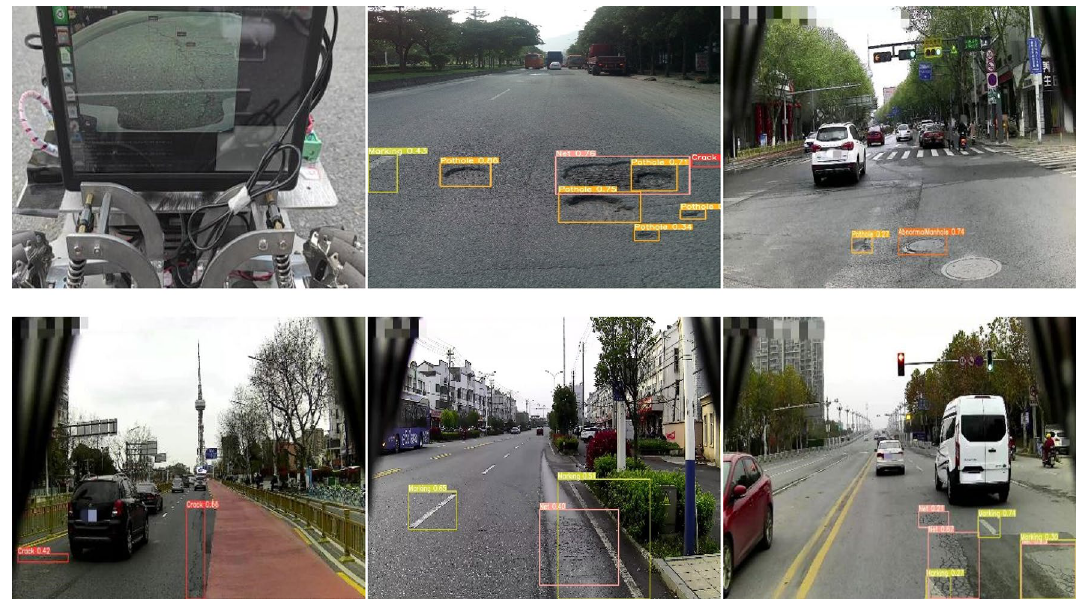
Figure 15. The deployment of the improved YOLOv5s in a self-built mobile platform and its object recognition results.